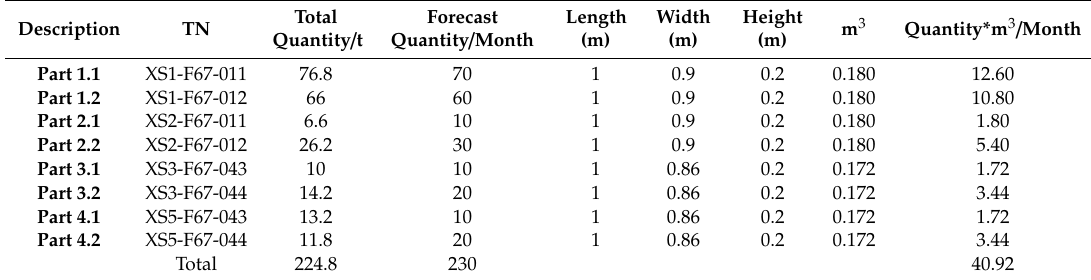
Table 5. Sales forecast with IDIS for 20XX.